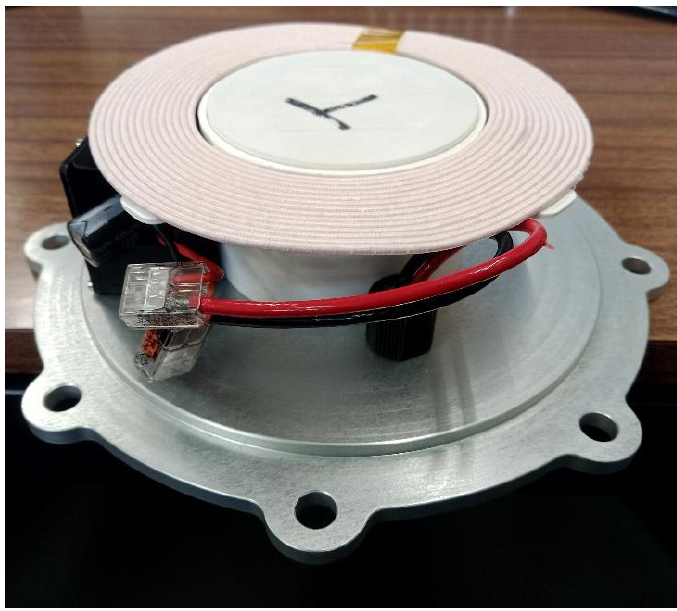
Figure 13. 48 V module transmitter assembled to the WCH lid.